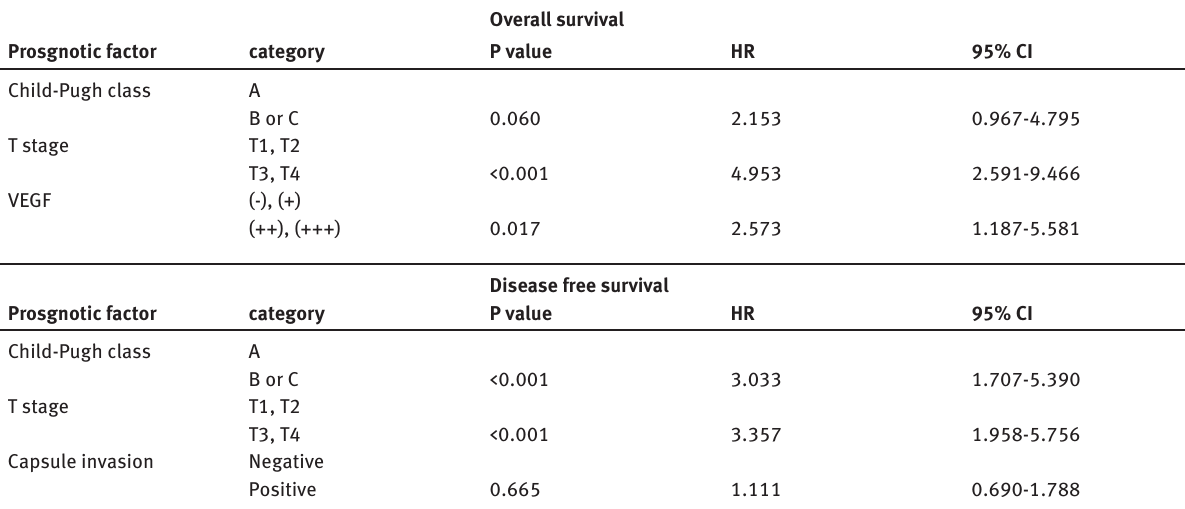
Table 3: Multivariate analysis of prognostic factors for overall survival and disease free survival